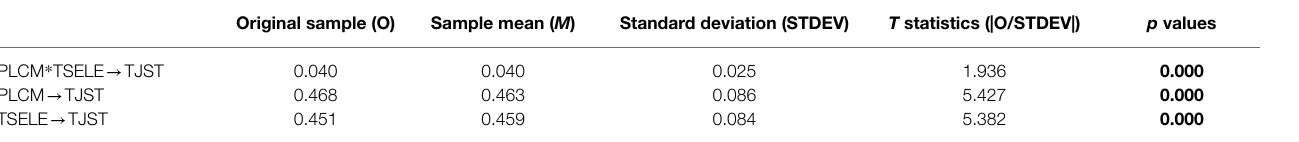
TABLE 5 | Regression